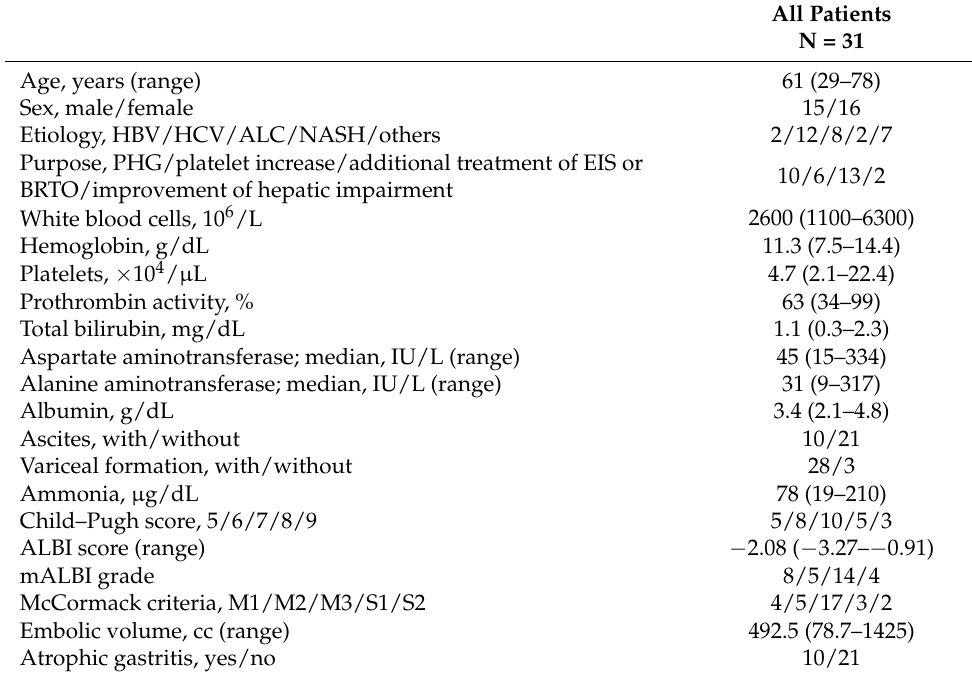
Table 1. Patients’